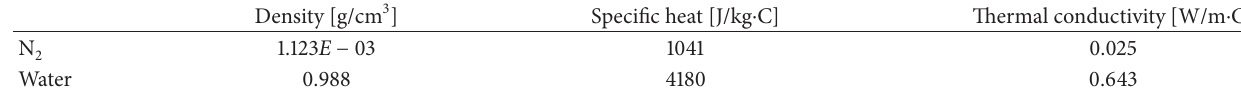
gas and water. 2